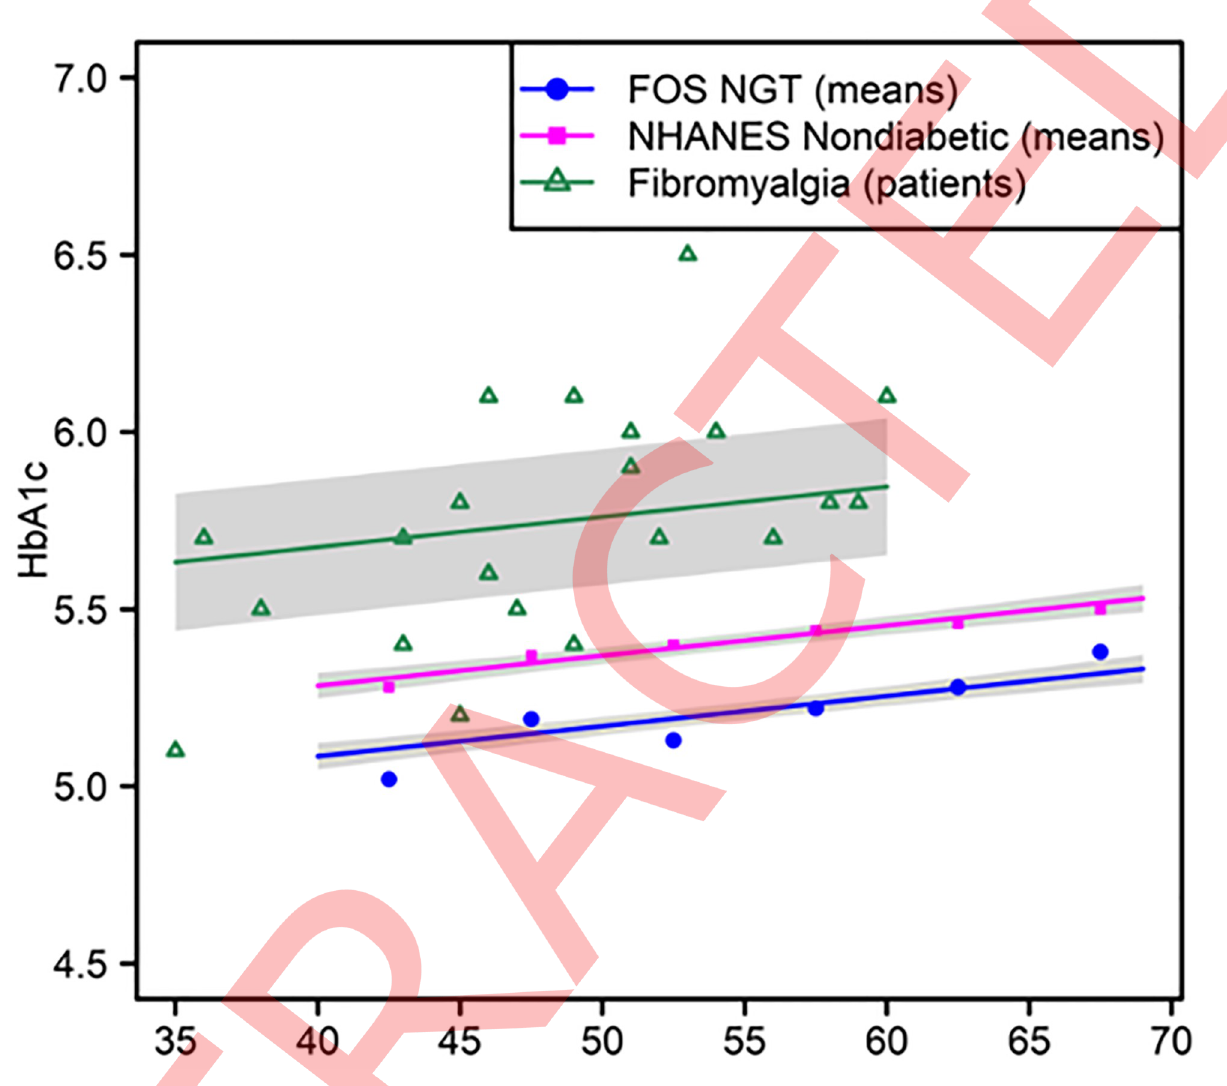
Fig 1. HbA1c in patients with fibromyalgia versus